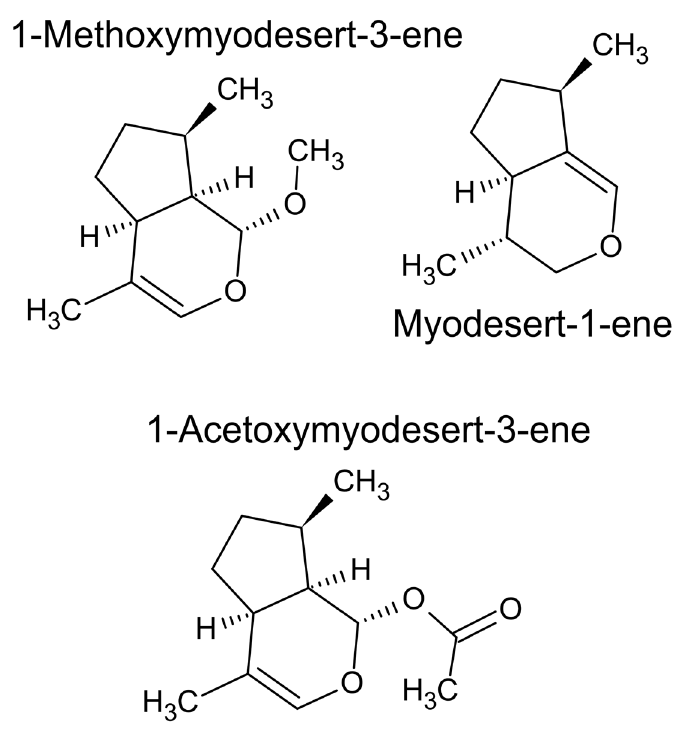
Figure 17. Unusual essential oil components from Eremophila deserti .